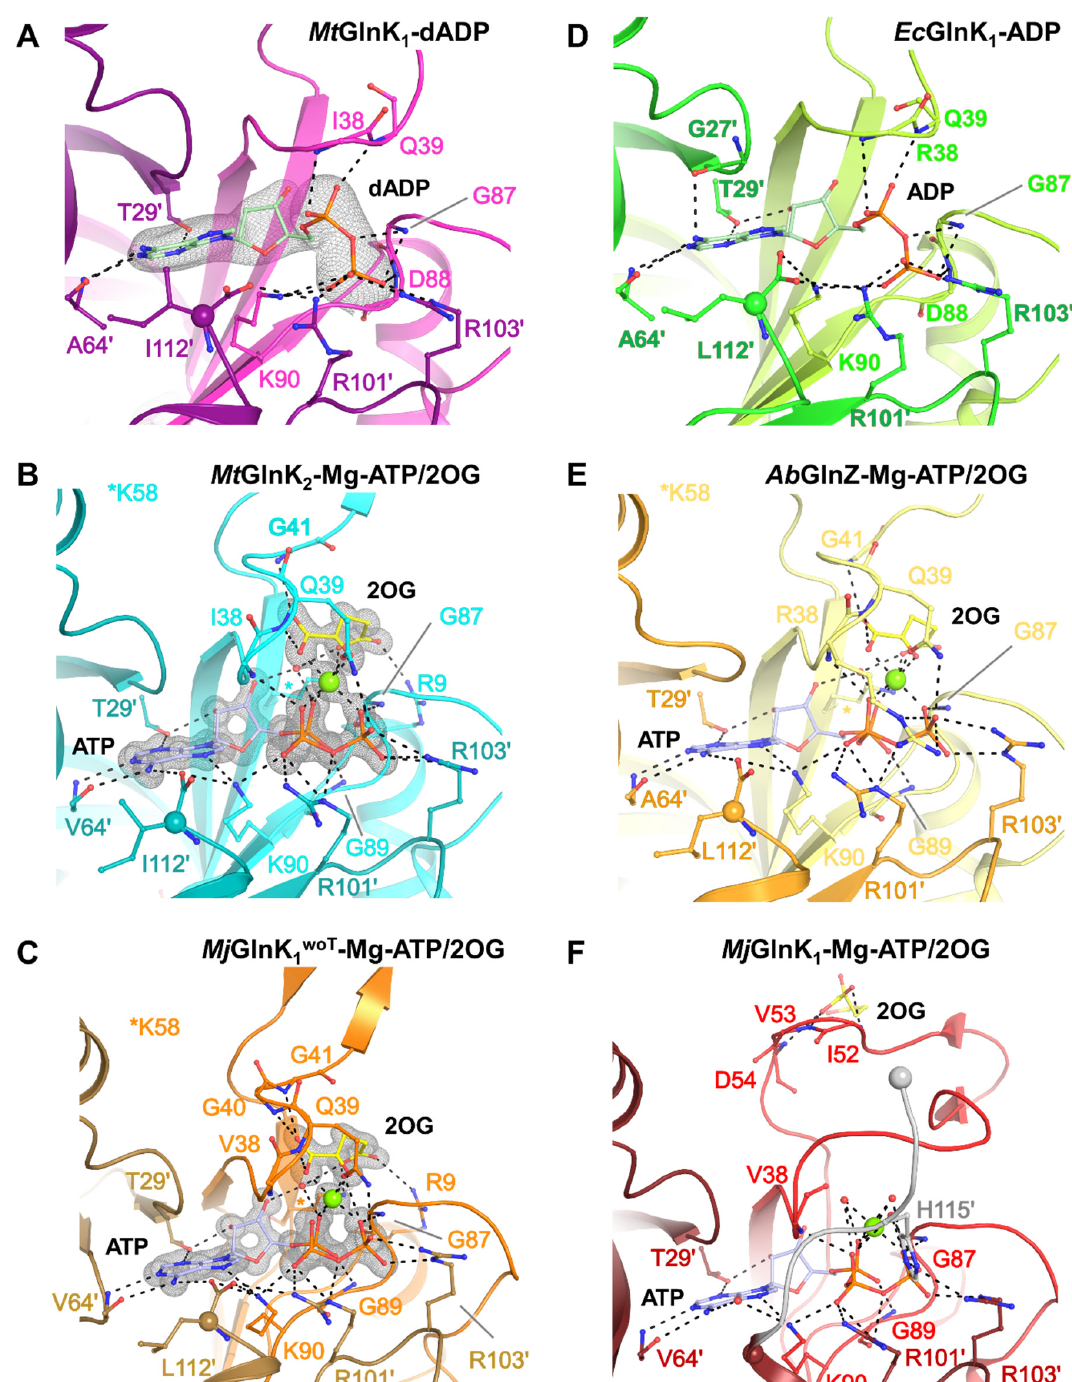
Figure 3. Ligand binding sites. For all panels, the main chain is represented in cartoon. Ligands, main and side chains of the residues participating in ligand binding are shown as ball and stick. Carbon atoms are colored in yellow for 2OG, in pale green for dADP and ADP, in pale blue for ATP while nitrogen, oxygen, phosphorus and Mg are colored in blue, red, orange and green, respectively. C-termini are highlighted by a sphere. Electron density maps (2 F o – F c ) around the ligands are contoured at 2- σ and shown as grey mesh. Polar contacts are indicated by black dashes. ( A ) Mt GlnK 1 -dADP, ( B ) Mt GlnK 2 -Mg-ATP/2OG, ( C ) Mj GlnK 1 woT -Mg-ATP/2OG, ( D ) E. coli GlnK-ADP (PDB:2NUU), ( E ) Azospirillum brasilense GlnZ-Mg-ATP/2OG (PDB:3MHY), ( F ) tagged Mj GlnK 1 -Mg-ATP/2OG (PDB:2J9E) with its C-terminal tag colored in light